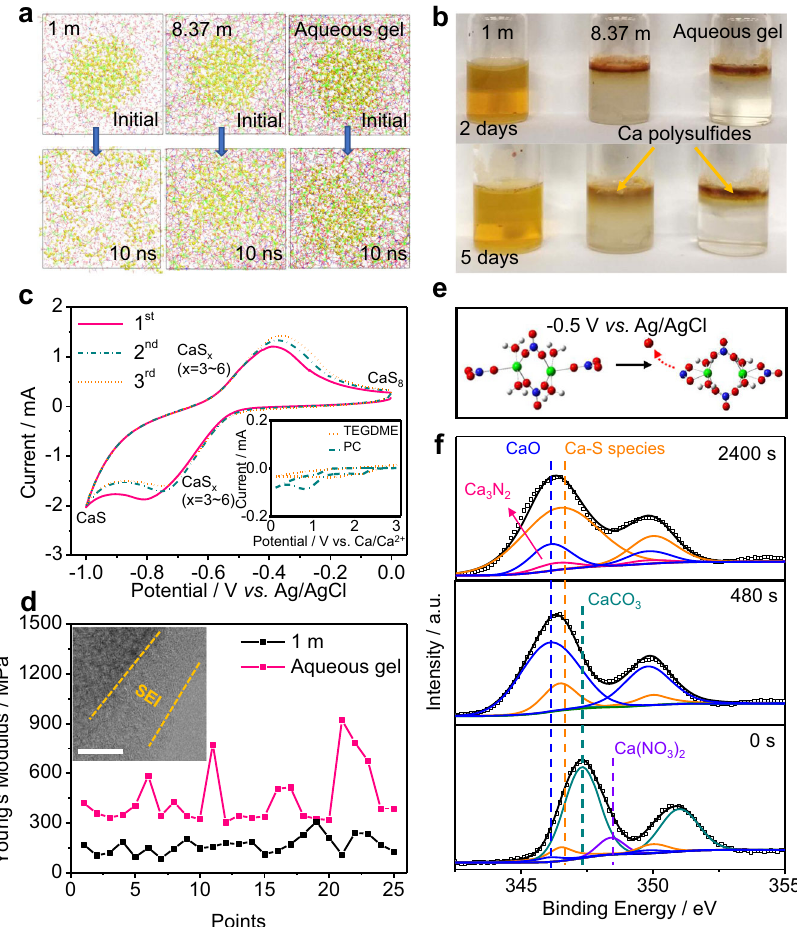
Fig. 3 Reaction mechanism of elemental sulfur in the aqueous gel electrolyte. a Local structure evolutions of CaS 4 (yellow) diffusions in 1 m, 8.37 m Ca (NO 3 ) 2 electrolytes, and aqueous gel electrolyte based on MD simulation. The yellow balls represent S atoms, and other symbols are same with those in Fig. 2a – c. b Visual observation of calcium polysul fi des diffusion in 1 m, 8.37 m Ca(NO 3 ) 2 electrolyte, and gel electrolyte. c The initial CV curves of S/C electrode collected at a scan rate of 0.2 mV s – 1 in the aqueous gel electrolyte. The CV curves of Ca metal||S/C cell with 0.5 m Ca(OTf) 2 in TEGDME or 0.5 m Ca(OTf) 2 in PC electrolytes at 0.2 mV s – 1 are shown in inset of Fig. 3c. d The Young ’ s Modulus of S/C anodes tested in 1 m Ca(NO 3 ) 2 and aqueous gel electrolytes. The points are selected from the AFM scanning images in Supplementary Fig. 16. The inset is HADDF – STEM images of S/C anodes after cycling in aqueous gel electrolyte, scale bar: 10 nm. e The DFT calculations of reduction of Ca 2 + (NO 3 – ) 3 (H 2 O) x aggregate. The green, blue, red, and white balls represent Ca, N, O, and H atoms, respectively. f In-depth Ca 2 p XPS of the S/C electrode after cathodic CV